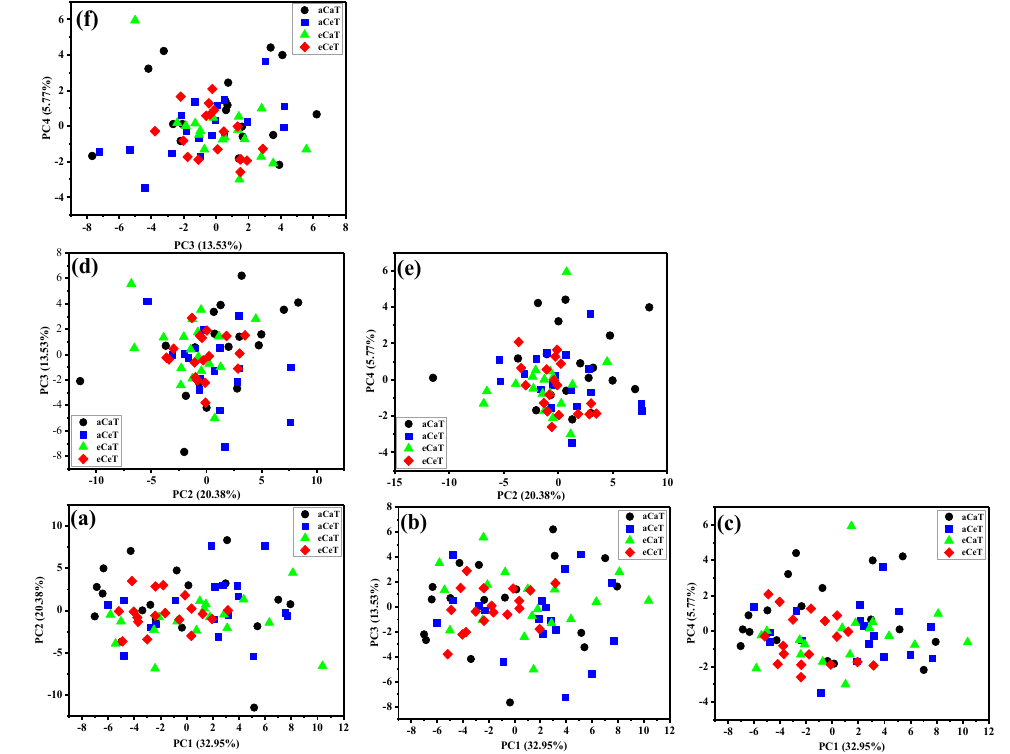
Figure 4. Principal component distributions of rice based on FTIR-PAS spectra (600–4000 cm − 1 ). ( a ): PC1-PC2 scatterplot; ( b ): PC1-PC3 scatterplot; ( c ): PC1-PC4 scatterplot; ( d ): PC2-PC3 scatter-plot; ( e ): PC2-PC4 scatterplot; ( f ): PC3-PC4 scatterplot; Note: aCaT, aCeT, eCaT, and eCeT refer to ambient conditions, increased temperature, elevated CO 2 , and the combination of elevated CO 2 and increased temperature, respectively.